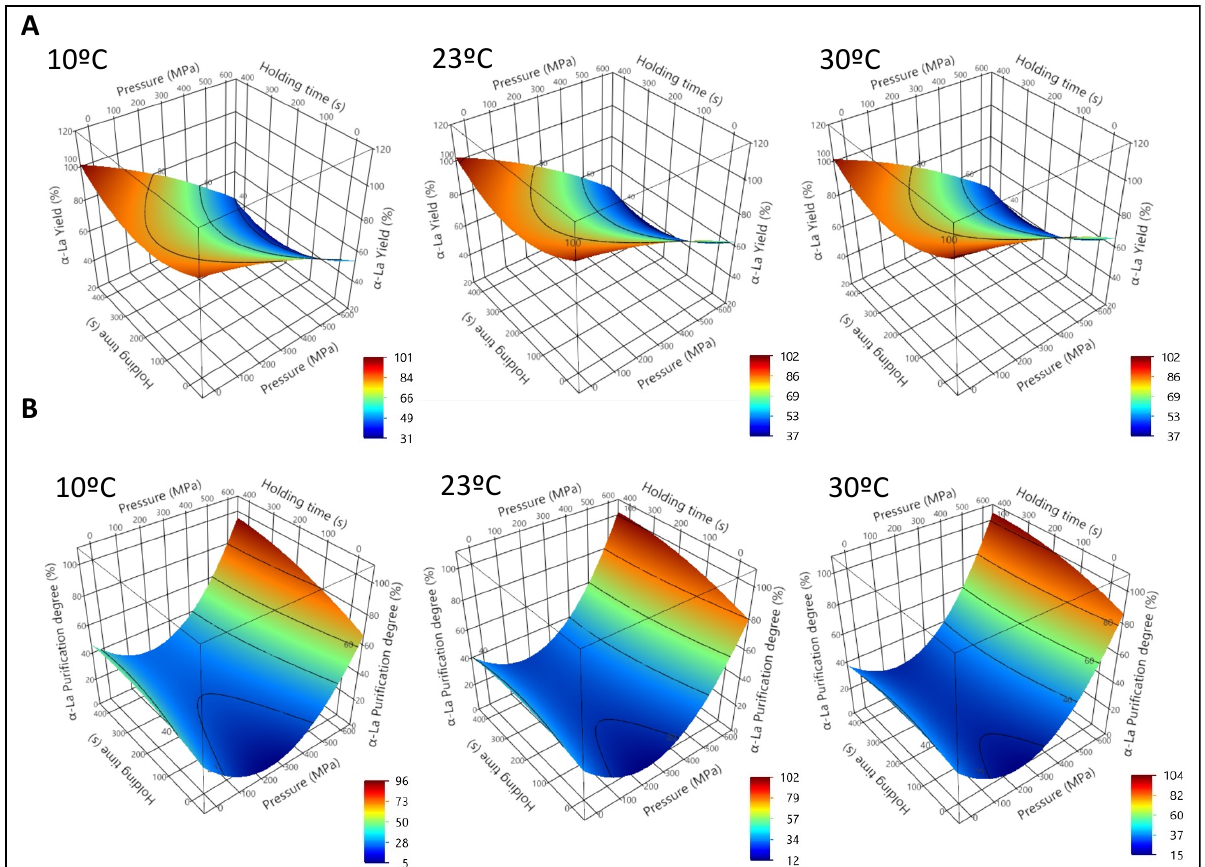
Figure 2. First experiment. Acidified (pH 4.6) native whey concentrate supernatant (NWC sup ). Representation of the surface responses for α -Lactalbumin yield ( A ) and α -La purification degree ( B ) after high-pressure processing (HPP) treatments as a function of pressure (P), holding time (t) and initial sample temperature (10 °C, 23 °C and 30 °C), according to the equations from Table S2.